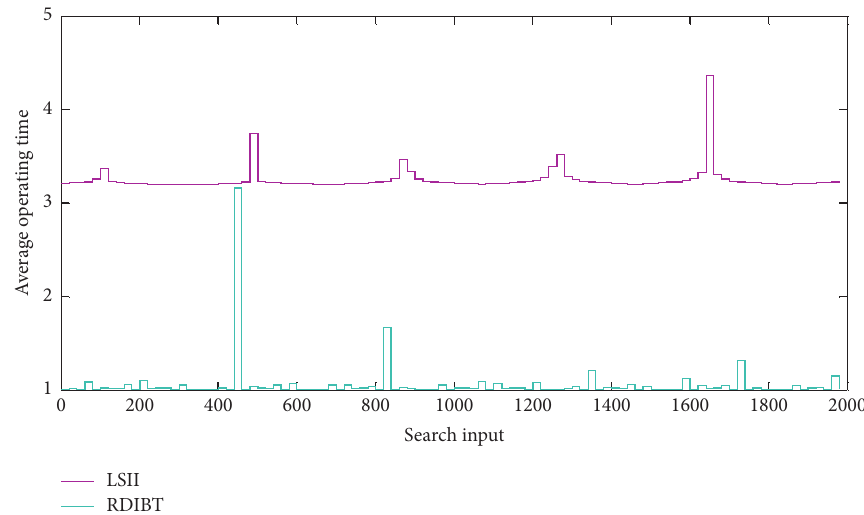
Figure 8: The average operation time to change the search input